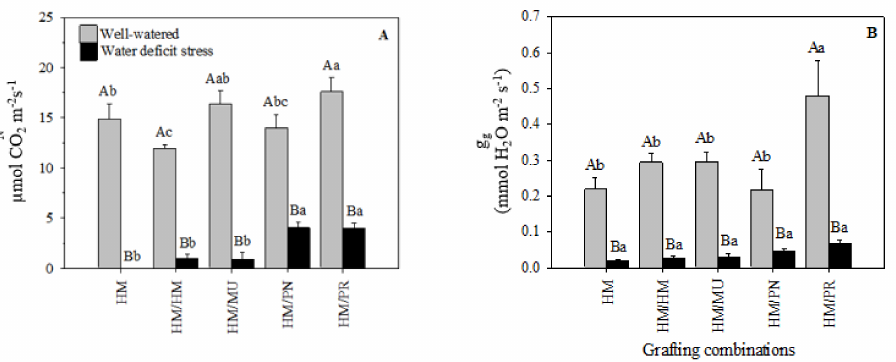
Figure 4. ( A ) Net photosynthetic rate (A N ) and ( B ) stomatal conductance (g s ) of five grafting com- binations under well-watered and water-deficit stress conditions. Capital letters denote significant differences between the water regimes within each graft combination and lower-case letters denote significant differences among the grafting combinations within each water regime according to the LSD test ( p ≤ 0.05). Columns are mean ± standard error. Note: HM = non-grafted HM 1823; HM/HM = HM 1823 self-grafted; HM/MU = HM 1823 grafted onto Multifort; HM/PN = HM 1823 grafted onto S. pennellii ; and HM/PR = HM 1823 grafted onto S. peruvianum . Eight days after water withholding, all grafting combinations also showed a significant reduction in stomatal conductance compared to their well-watered controls (Figure